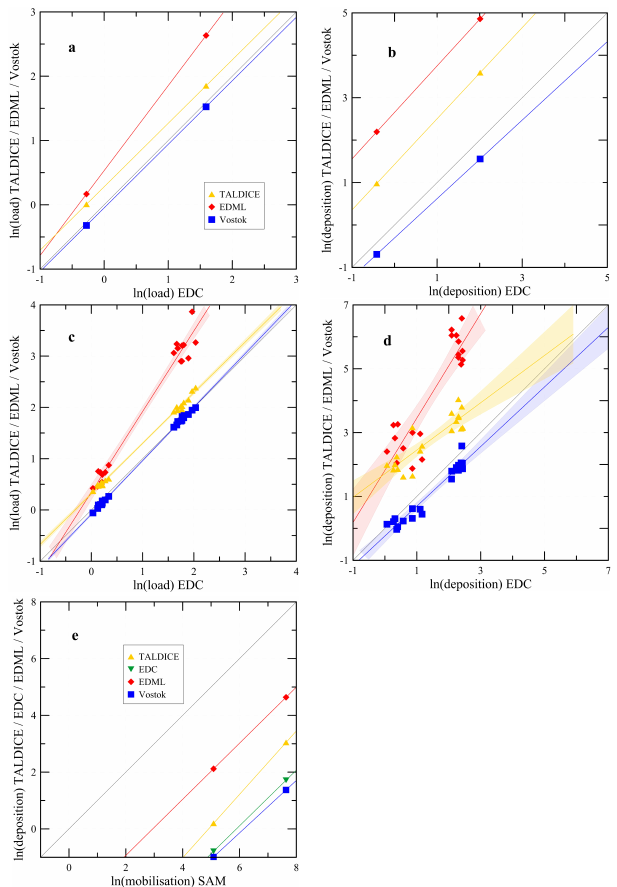
Fig. 7. (a) Dust column load of 1yr tuned model runs at ice core grid points (Albani et al., 2012b). Double-logarithmic plots at EDML (red diamonds), Vostok (blue squares), and TALDICE (yellow tri- angles) versus EDC. (b) Double-logarithmic plots of modelled dust deposition for all drill sites. The results are from the same model run as in (a) . (c) Results of two 10yr simulations showing inter-annual variability (10 points for each climate period) of the dust column load. Double-logarithmic scatter plots at EDML (red diamonds), Vostok (blue squares), and TALDICE (yellow triangles) vs. EDC, with the linear regressions including significance intervals (95%) indicated in respective colours. See Table 2 for slopes, standard deviations, and r 2 values of the regressions shown in this figure. (d) Double-logarithmic plots of two 10yr simulations for all drill sites showing inter-annual variability of the dust deposition. The results are from the same model run as in (c) . Linear regressions including significance intervals (95%) are indicated in respective colours. (e) Double logarithmic scatter plot of the source mobili- sation vs. deposition showing the relation of dust deposited at the four ice core sites originating from a unique source (South Amer- ica, SAM) based on the 1yr tuned case of Albani et al. (2012b). Green triangles represent EDC.